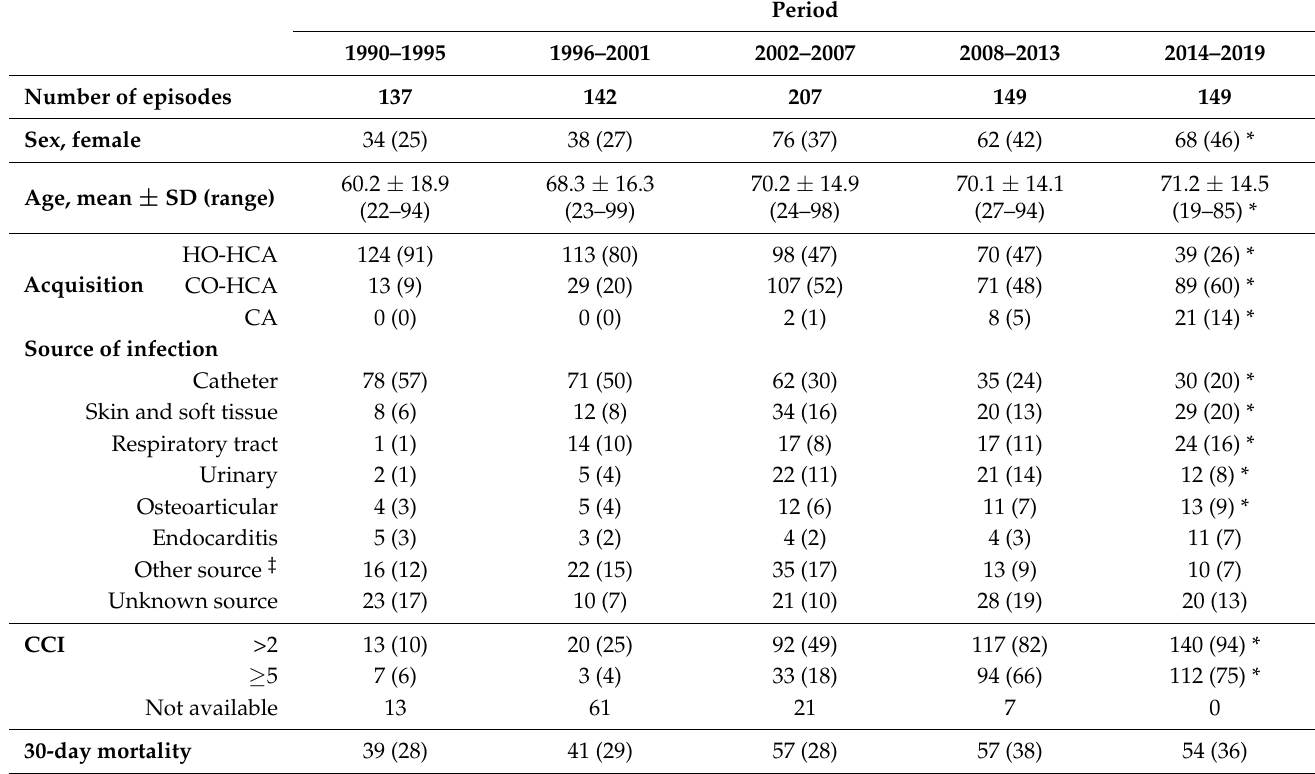
Table 1. Clinical and demographic characteristics of MRSA-BSI episodes by period. The table shows the total number of episodes and the percentages (in